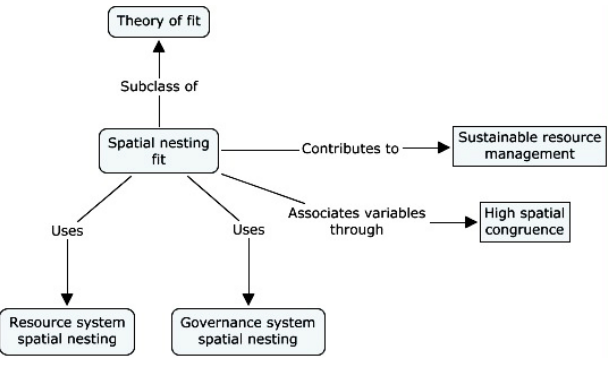
Fig. 6 . Spatial nesting